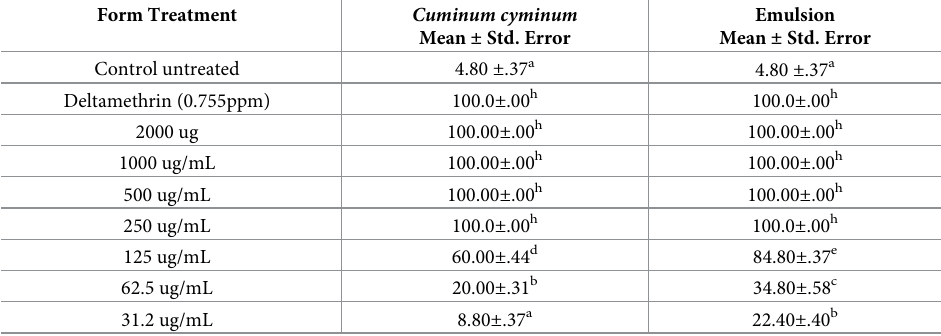
Superscript of the same letter in cells of the same column shows a non-significant effect in respect to the non-treated control. Superscript of different letters in cells of the same column shows a significant effect in respect to the non- treated control ( P � 0.05).